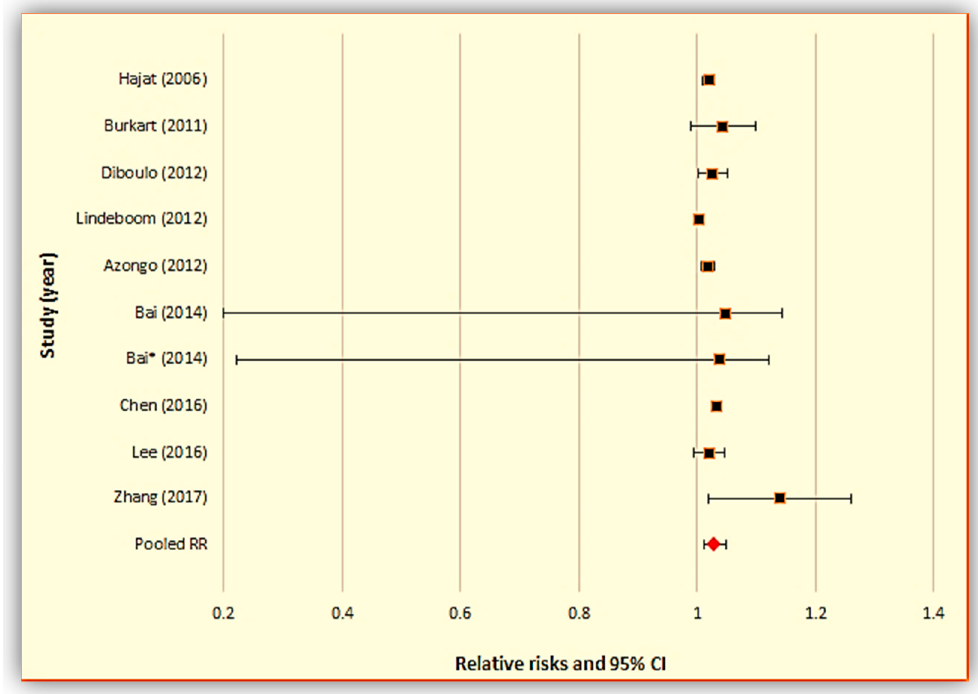
Figure 3. Meta ‐ analysis results for studies using daily mean temperature for all ‐ cause mortality.